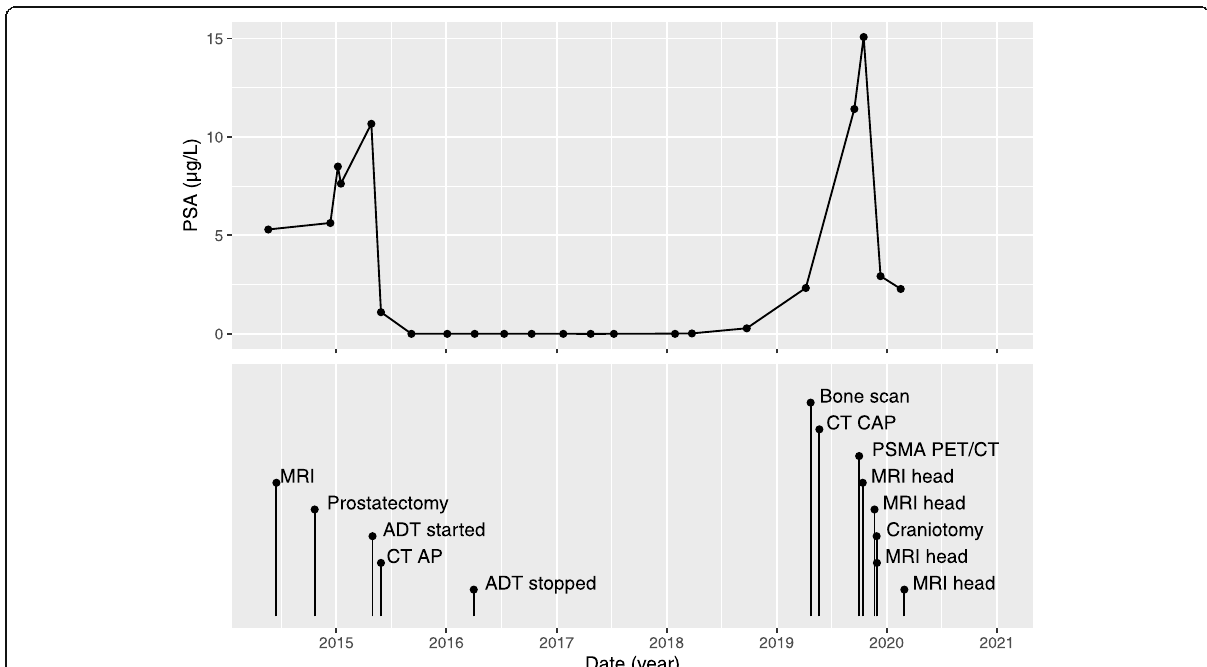
Fig. 1 Serum PSA, with procedures, over time. Top: serum PSA ( μ g/L) over time (values of < 0.02 μ g/L are plotted as 0 μ g/L); bottom: procedures over